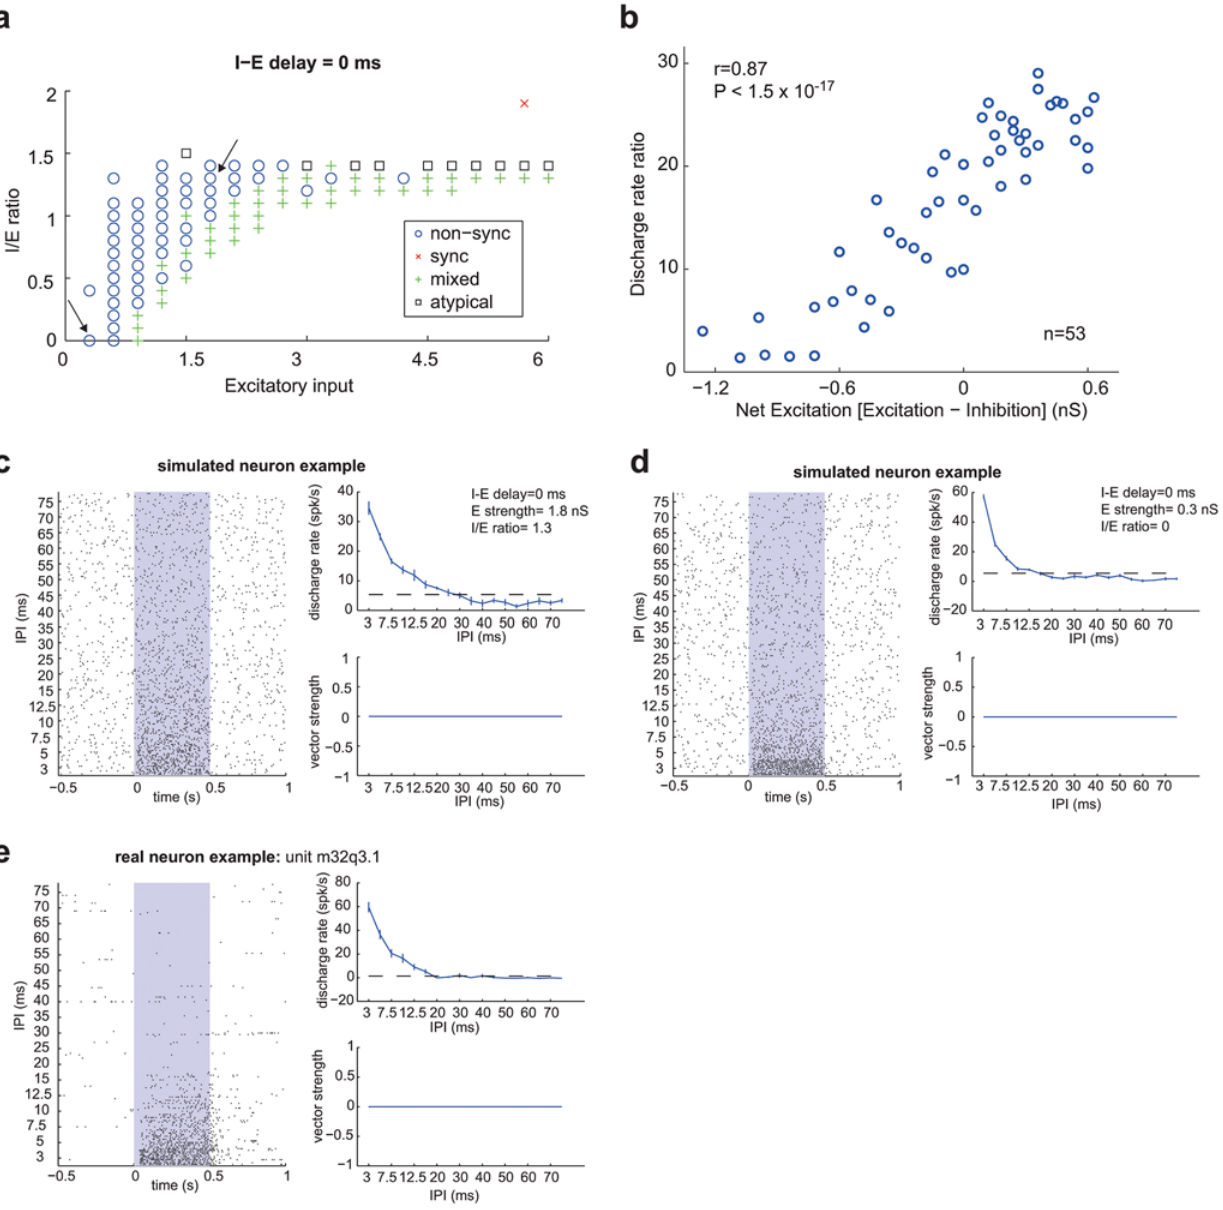
Fig 5. Simulated non-synchronized neuron. a. Classification of neuron-type [non-sync (o), sync (x), mixed (+), atypical (square)] across two parameters (Excitatory input and I/E ratio), with a fixed I-E delay of 0 ms. The two arrows indicate the parameters used for the simulated neurons in Fig. 5c (right arrow) and Fig. 5d (left arrow). b. Dependence of discharge rate ratio on net excitatory input (excitation-inhibition). Spearman correlation coefficient: r = 0.87, P < 1.5 x 10 -17 in simulated non-synchronized neurons. c-e. Examples of simulated and real non-synchronized neurons. Each plot is subdivided into a raster plot (left), IPI vs discharge rate plot (top right), and IPI vs vector strength plot (bottom right). The stimulus is played for 500 ms, which is indicated with the gray rectangle in the raster plot. The dashed line in the IPI vs discharge rate plot indicates a significant evoked response above the spontaneous rate (2 σ ). Error bars indicate SEM. c. Simulated neuron: I-E delay = 0 ms, E strength = 1.8 nS, I/E ratio = 1.3. d. Simulated neuron: I-E delay = 0 ms, E strength = 0.3 nS, I/E ratio = 0. e. Real neuron: (unit m32q3.1) from awake marmoset auditory cortex.